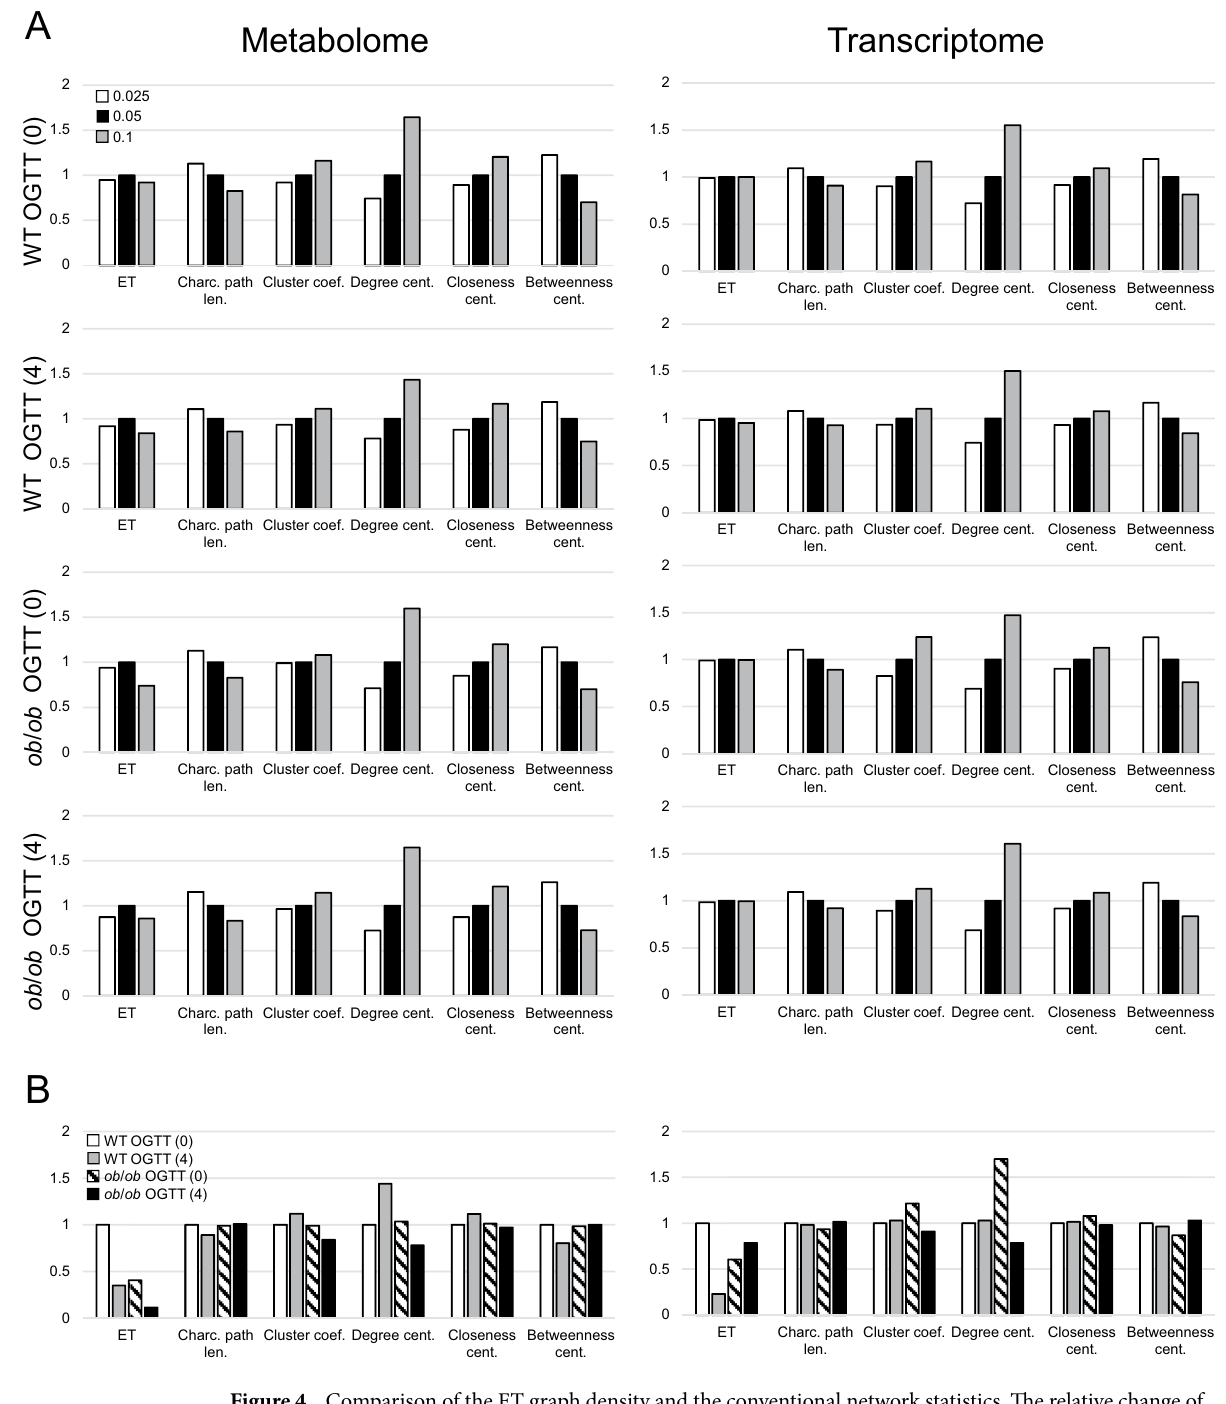
Figure 4. Comparison of the ET graph density and the conventional network statistics. The relative change of Spearman correlation coefficient of the ET graph density and the conventional network statistics against the p < 0.05 network in each condition ( A ) and of different conditions against the WT OGTT (0) network ( B ) in the metabolome (left column) and transcriptome (right column). Each value is normalized such that the value of p < 0.05 becomes one in ( A ) and that of WT OGTT (0) become one in ( B ). ET, Charc. path len., Cluster coef., Dgree cent., Closeness cent., and Betweenness cent. stand for absolute value of Spearman correlation coefficient of ET graph density, characteristic path length, cluster coefficient, the average of degree centrality, the average of closeness centrality, and the average of betweenness centrality,